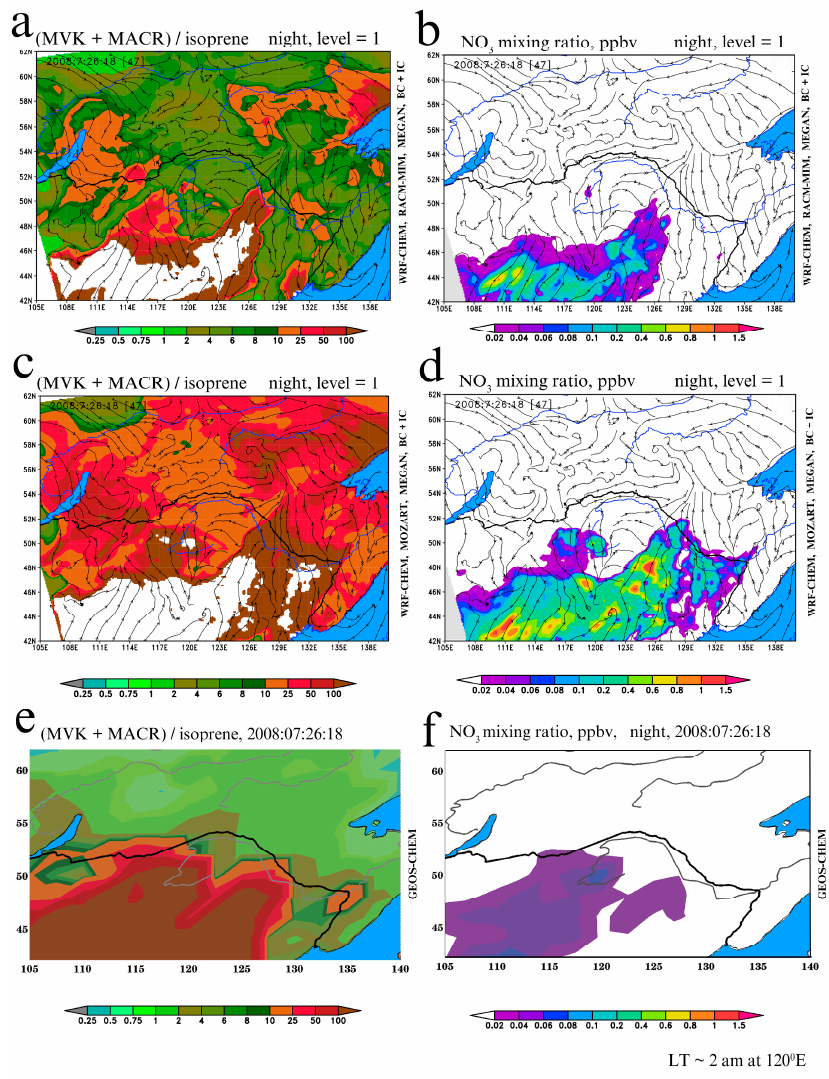
Figure 10. An example of the nocturnal chemical reaction maps of the ratio at 26.07.2008 18:00 UTC (~2 am LT next day at 120 ◦ E), simulated by RACM-MIM ( a ) and MOZART ( c ) gas-phase mechanisms of the WRF-CHEM model and using the global GEOS-CHEM 2 × 2.5 ◦ model ( e ). In the regional simulation, the long-range transport from the central industrial districts of China is taken into account. The white areas correspond to the values of the ratio >>100, where the isoprene is missing. Spatial distributions of NO 3 concentrations, calculated by the RACM-MIM mechanism ( b ), MOZART mechanism ( d ) and GEOS-CHEM ( f ), are presented. In addition, the (u,v) streamlines at the surface level of WRF-ARW meteorological fields were presented in ( a – d ) to visualize the direction of species flows.